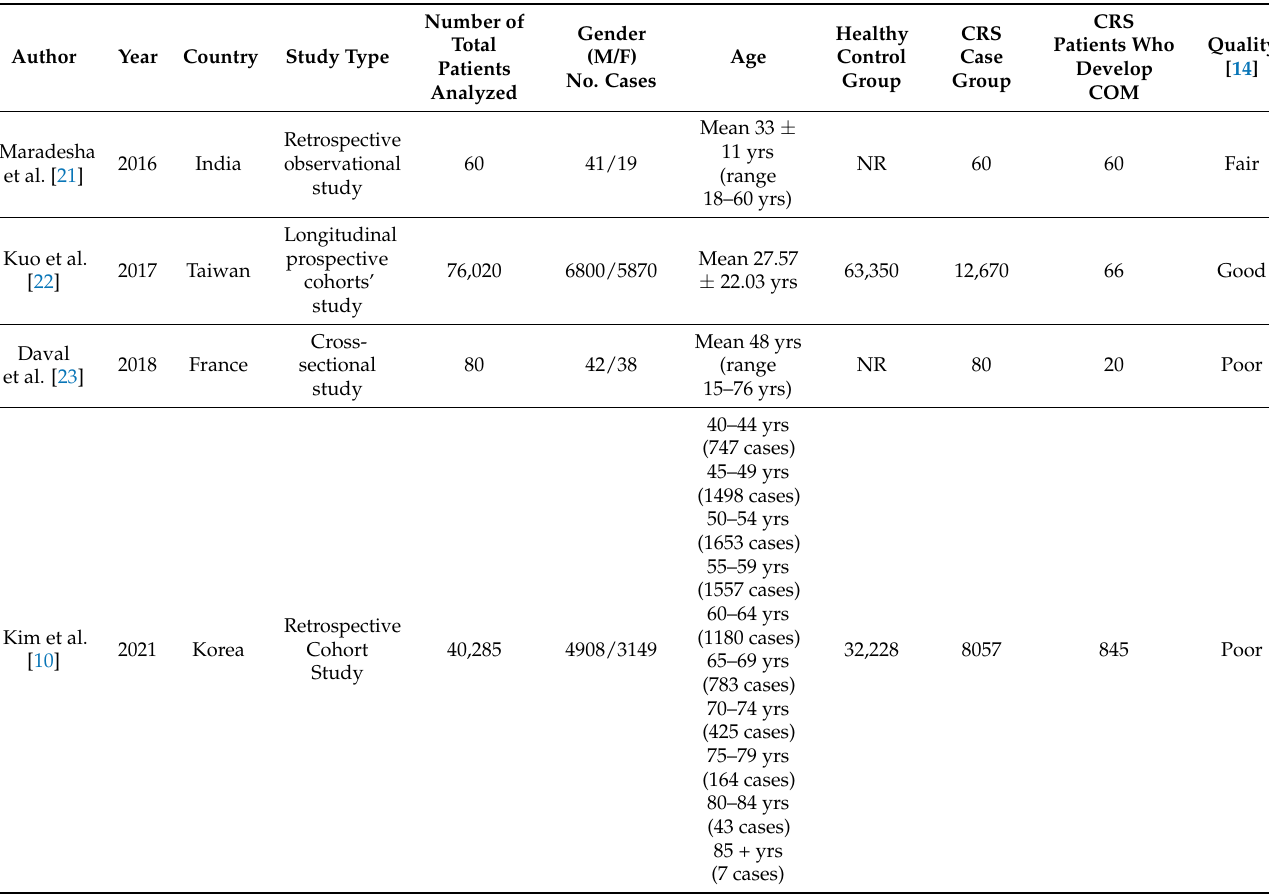
Table 1. Summary of studies included in the review and their quality according to the National Institutes of Health quality assessment tool for Observational Cohorts and Cross-Sectional Studies